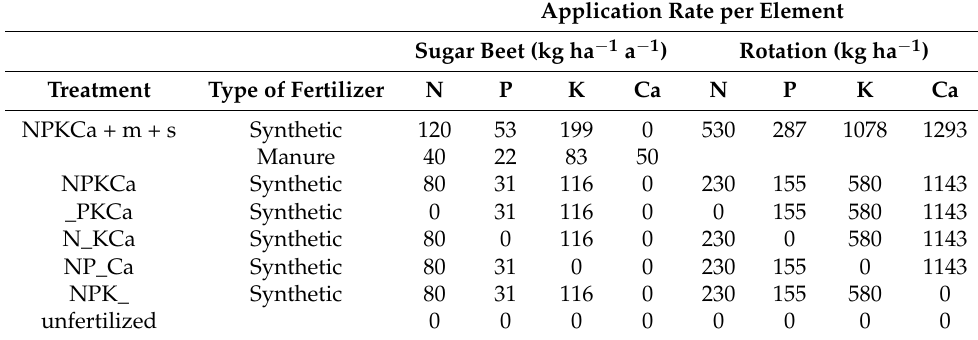
Table 1. Nutrients and fertilizer type applied at sugar beet in kg ha − 1 a − 1 and at the five year rotation in kg ha − 1 since 1953 at the long term fertilizers experiment